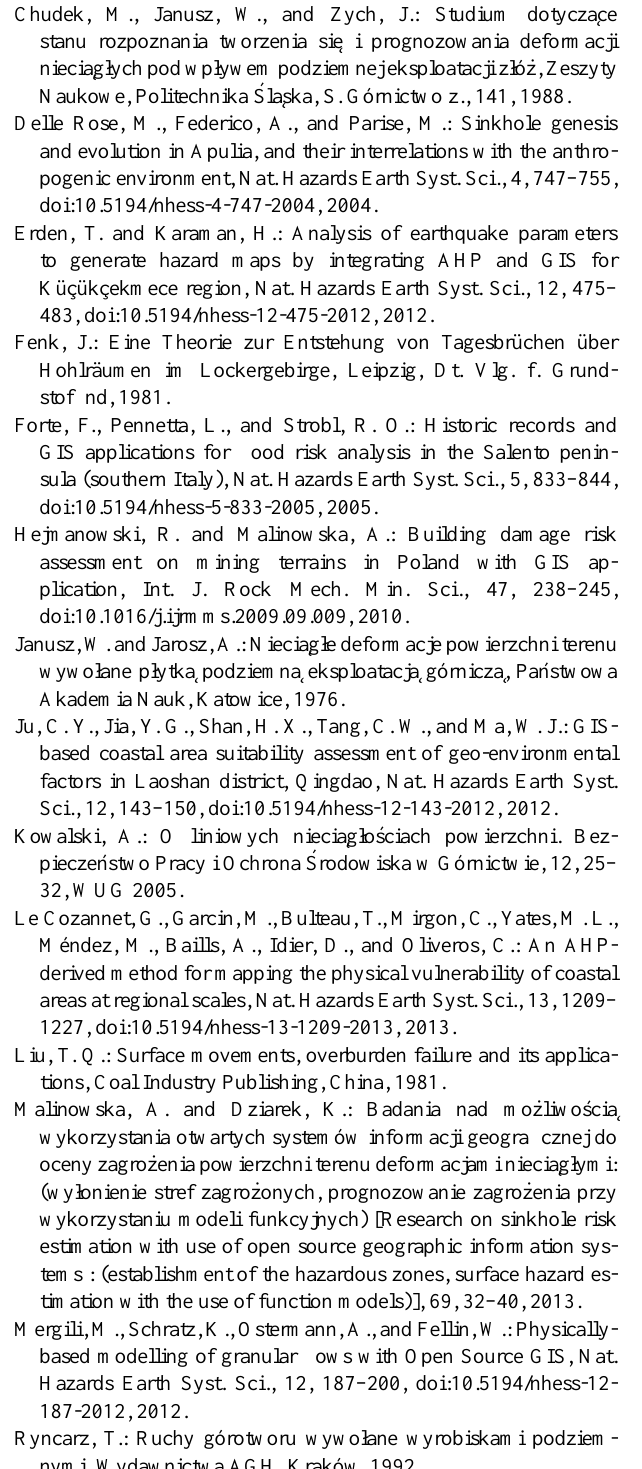
Table 5. Evaluation of reliability of presented model. AHP Number of